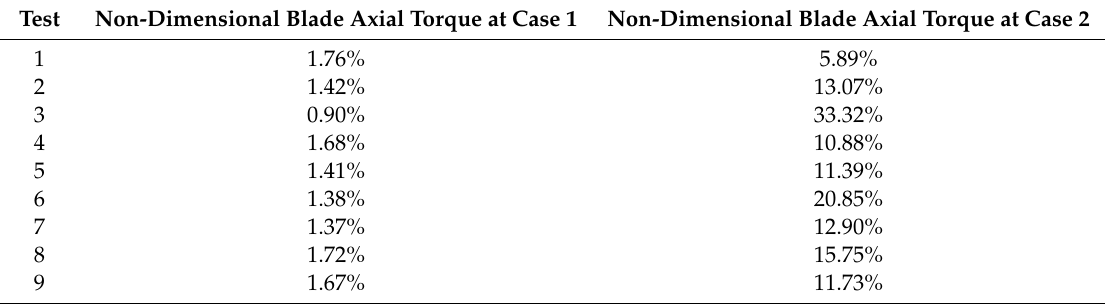
Table 5. Blade axial torque increment comparison between the nine tests.